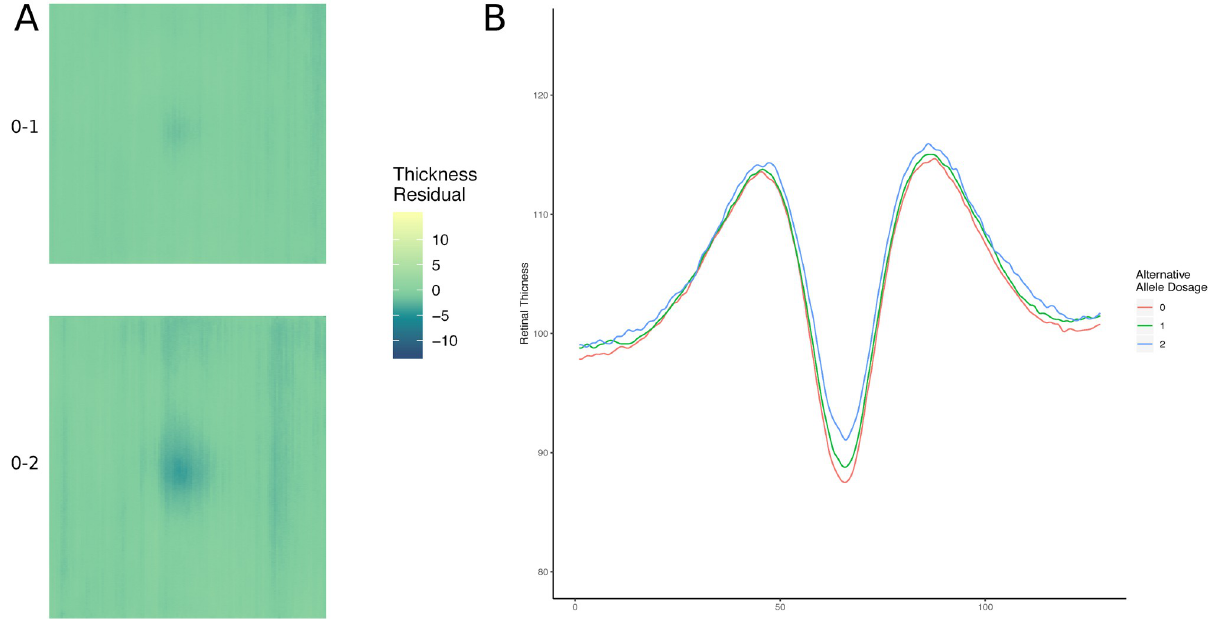
Fig 3. Higher dimensional detailed retinal phenotyping. (A) A model of the macular field showing the difference in mean total retinal thickness between those with homozygous reference and heterozygous alleles (top), and homozygous reference and homozygous alternative alleles (bottom) at rs1042602 ( TYR ). (B) Models of the mean overall retinal thickness across three groups defined by their allele state, homozygous reference (0), heterozygous (1) or homozygous alternative (2) at rs1042602 ( TYR ). The y axis represents total retinal